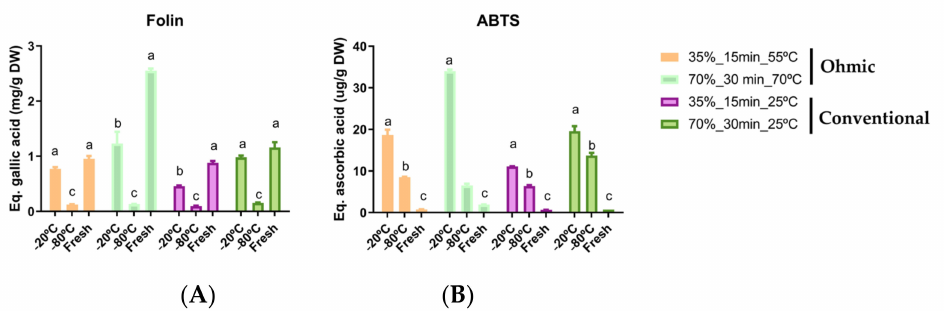
Figure 3. Total phenolic compounds ( A ) and total antioxidant activity ( B ) from fresh and frozen samples submitted to ohmic and conventional extractions. The different letters in each methodology represent significant differences between samples ( p <